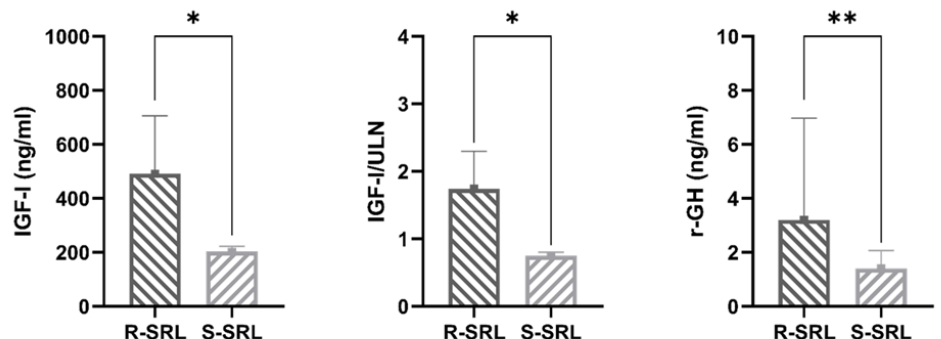
Figure 3. Median values of biochemical disease control parameters at enrolment in patients resistant (R-SRL) and in those responsive to somatostatin receptor ligands (S-SRL) (* p < 0.0001, ** p = 0.0002). Table 1. Main characteristics of the acromegaly population (96 patients) at the recruitment.